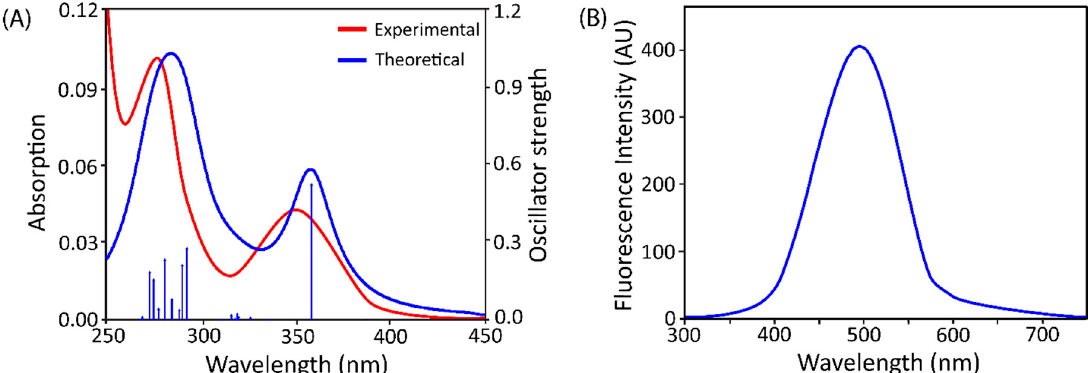
Figure 1. Experimental (red) and DFT simulated (blue) FTIR spectra of [Zn(sal)](H 2 O) complex.